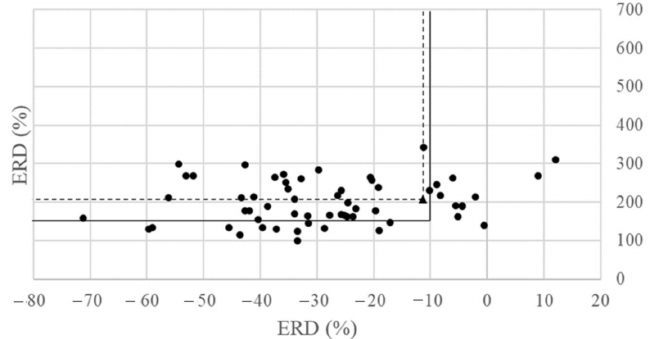
Figure 8. Plot of ERD ratio of change ( x -axis) vs. ERS ratio of change ( y -axis) derived from SSD. Dotted lines indicate ERD/ERS criteria as set by session 31 (triangle). Solid lines indicate the criteria for ERD < − 10% and ERS > 150%. The number that satisfies these criteria is the number of points in the upper-left section as demarcated by the respective lines.